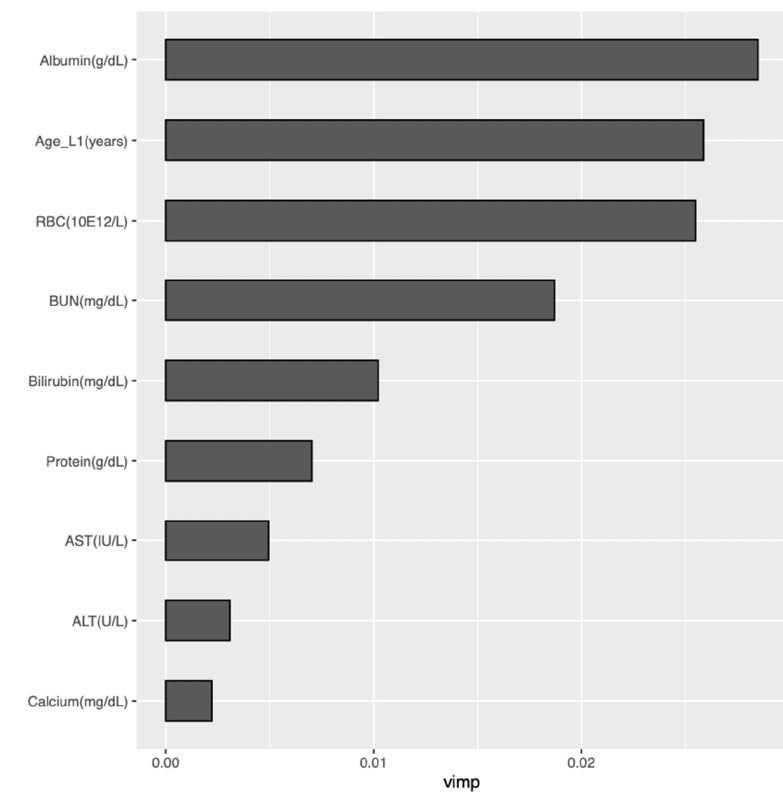
24 months of initiation of first-line treatment.